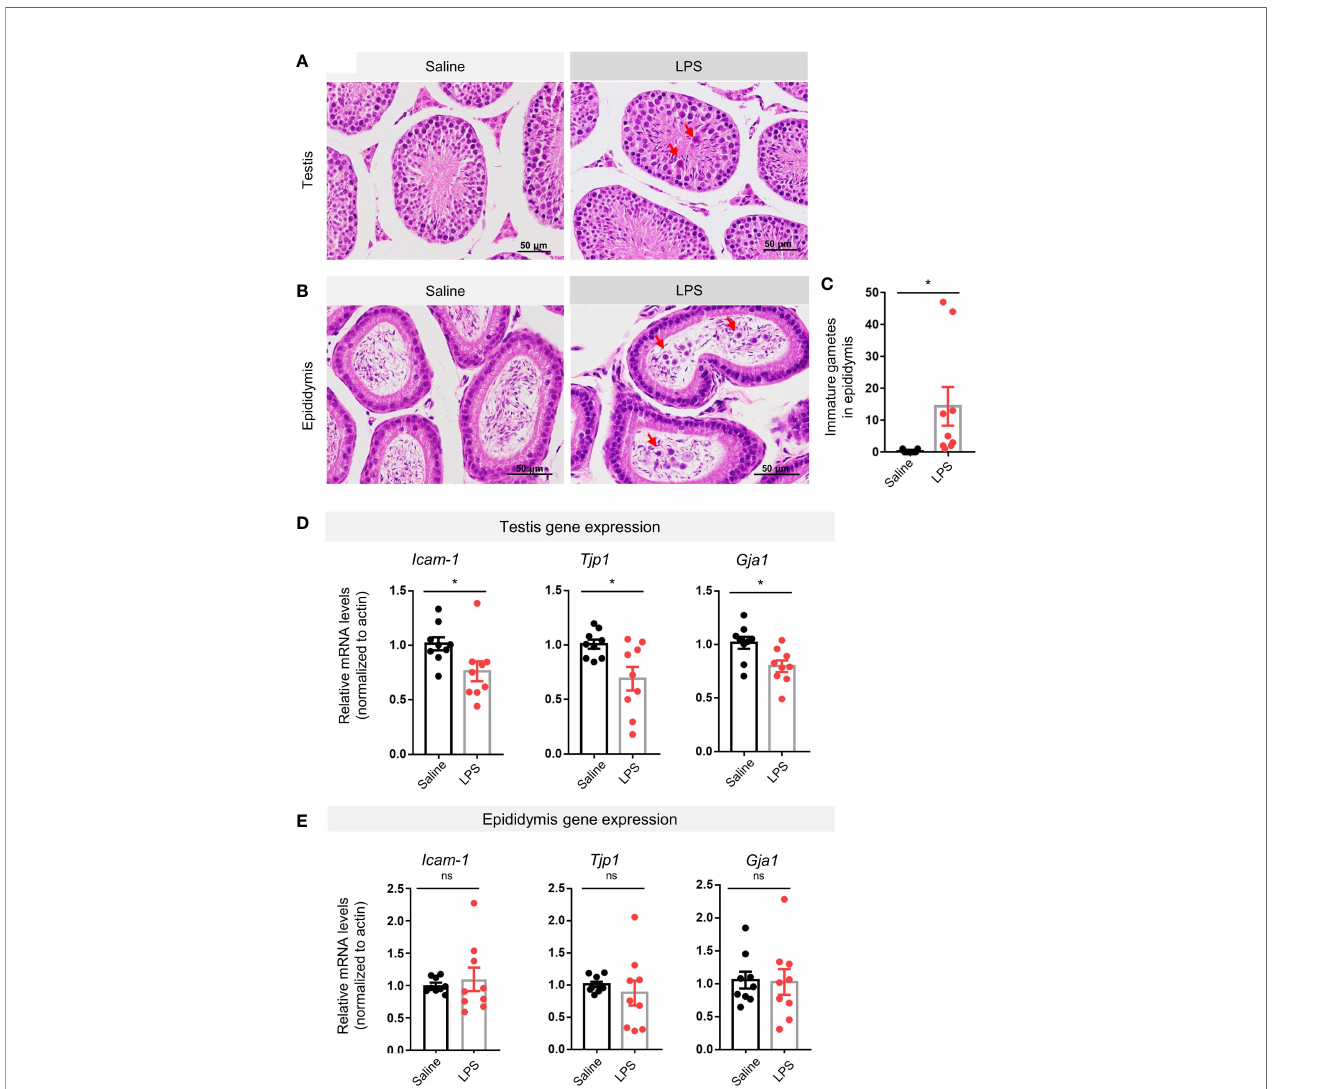
FIGURE 2 | LPS treatment resulted in impaired spermatogenesis and disrupted blood – testis barrier-related genes expression. (A) LPS-treated mice showed immature germ cells dropped from the testicular wall (H&E staining, scale bars = 50 m m). (B, C) LPS-treated mice showed that immature germ cells accumulated in the lumen of epididymis, which were quantitatively different to control in cell count numbers (H&E staining, scale bars = 50 m m; data are presented as mean ± SEM, n = 9 saline, n = 9 LPS; Student ’ s t-test, *p < 0.05). (D, E) The LPS-treated group had lower gene expression levels of intercellular adhesion molecule 1 ( Icam-1 ), tight junction protein 1 ( Tjp1 ), and gap junction alpha-1 protein ( Gja1 ) than controls, while no such changes were observed in the epididymis of the LPS-treated mice (data are presented as mean ± SEM, n = 9 saline, n = 9 LPS, *p < 0.05, ns, p >